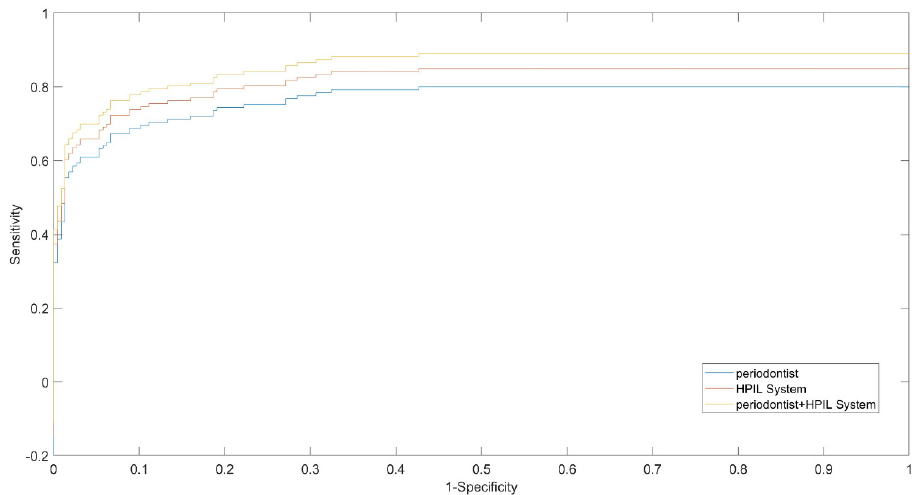
Figure 22. Comparative ROC between periodontist, HPIL system, and HPIL system with the periodontist .